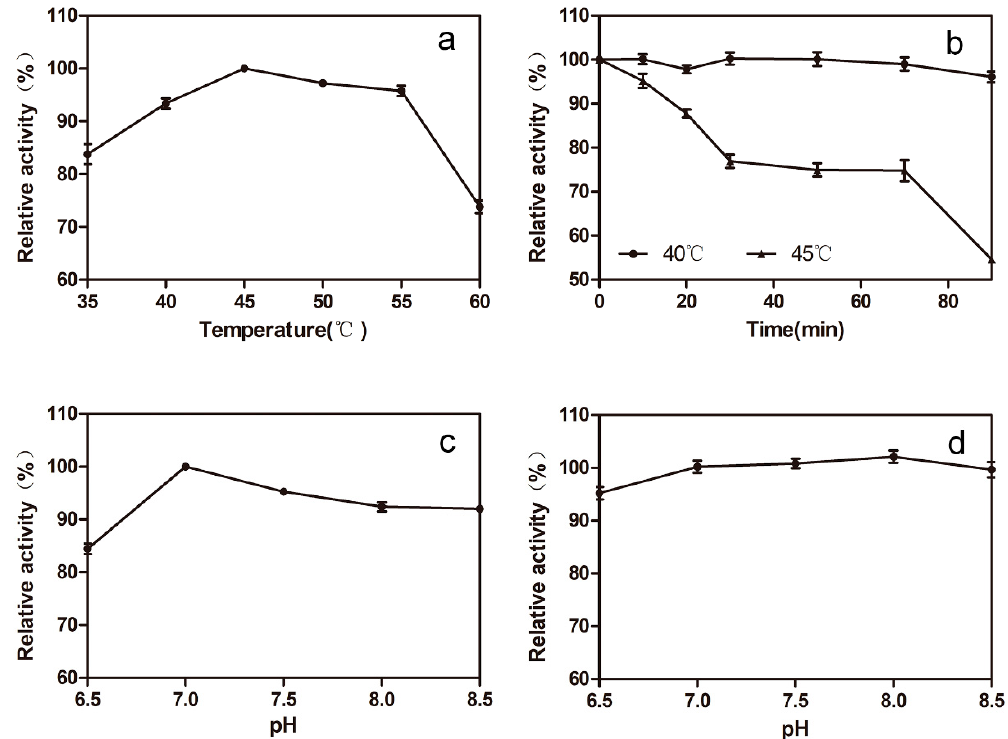
Figure 3. The e ff ects of pH and temperature on the activity and stability of 78D1. ( a ) E ff ects of Figure 3. The effects of pH and temperature on the activity and stability of 78D1. ( a ) Effects of temperature on 78D1 activity. ( b ) The thermostability of 78D1. ( c ) E ff ects of pH on 78D1 activity. temperature on 78D1 activity. ( b ) The thermostability of 78D1. ( c ) Effects of pH on 78D1 activity. ( d ) ( d ) E ff ects of pH on 78D1 stability. The initial activity was defined as Effects of pH on 78D1 stability. The initial activity was defined as 100%.